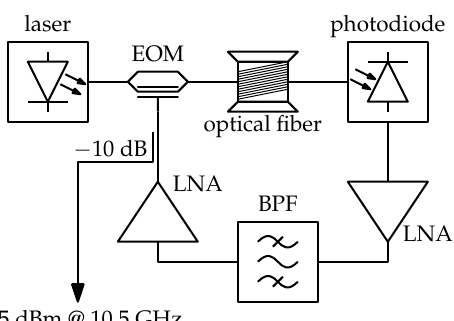
Figure 7. Opto-electronic oscillator built for measurement with the presented photonic delay phase noise meter.